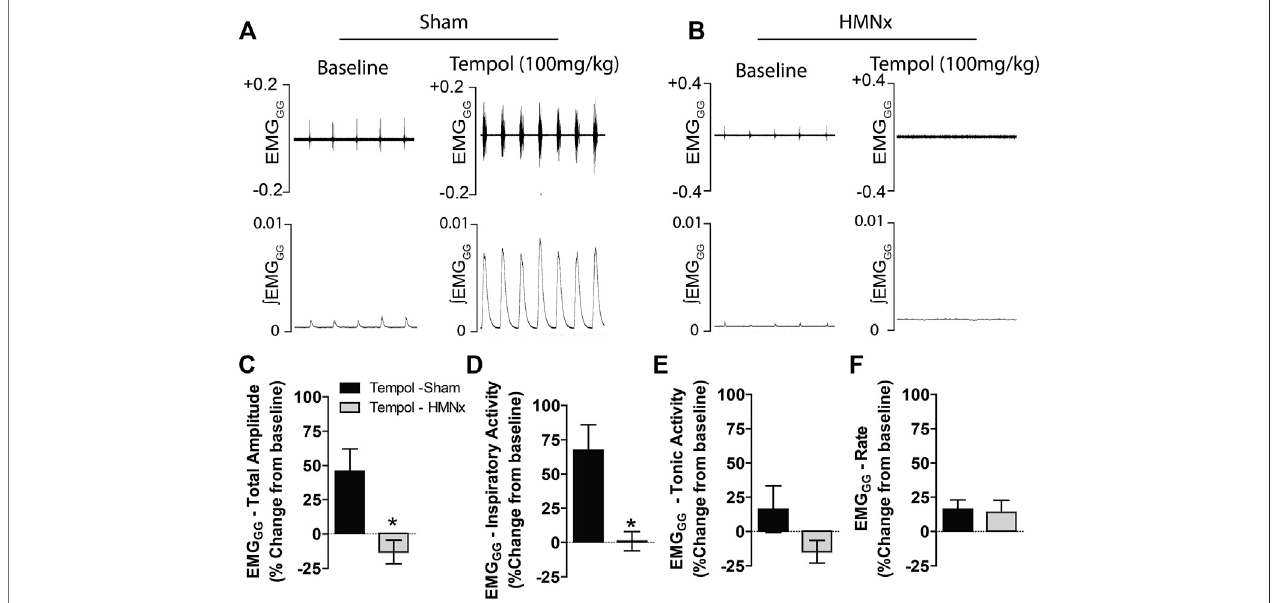
FIGURE6| Bilateralhypoglossalnerve transection(HMNx) abolishedTempol-induced effectsongenioglossusmuscleactivity (EMG GG ).Representativerecording showingthatthebolusinjectionofTempol(100 mg/kg,IV)elicitedpronounced increasesinEMG GG totalamplitudeandinspiratoryactivityinsham-operatedrats (Panel A) but notinratsafterbilateralHMNx (PanelB) .SummarydatashowingthatTempol(100 mg/kg,IV)increasedtotalamplitude (PanelC) andinspiratoryactivity (Panel D) insham-operatedbutnotinHMNxrats.Tempol(100 mg/kg,IV)didnotaffecttonicactivities (PanelE) orburstfrequency(rate) (PanelF) inbothgroups.Values are presented as mean ± SEM. There were six rats in each group. * p < .05, signi fi cant change from